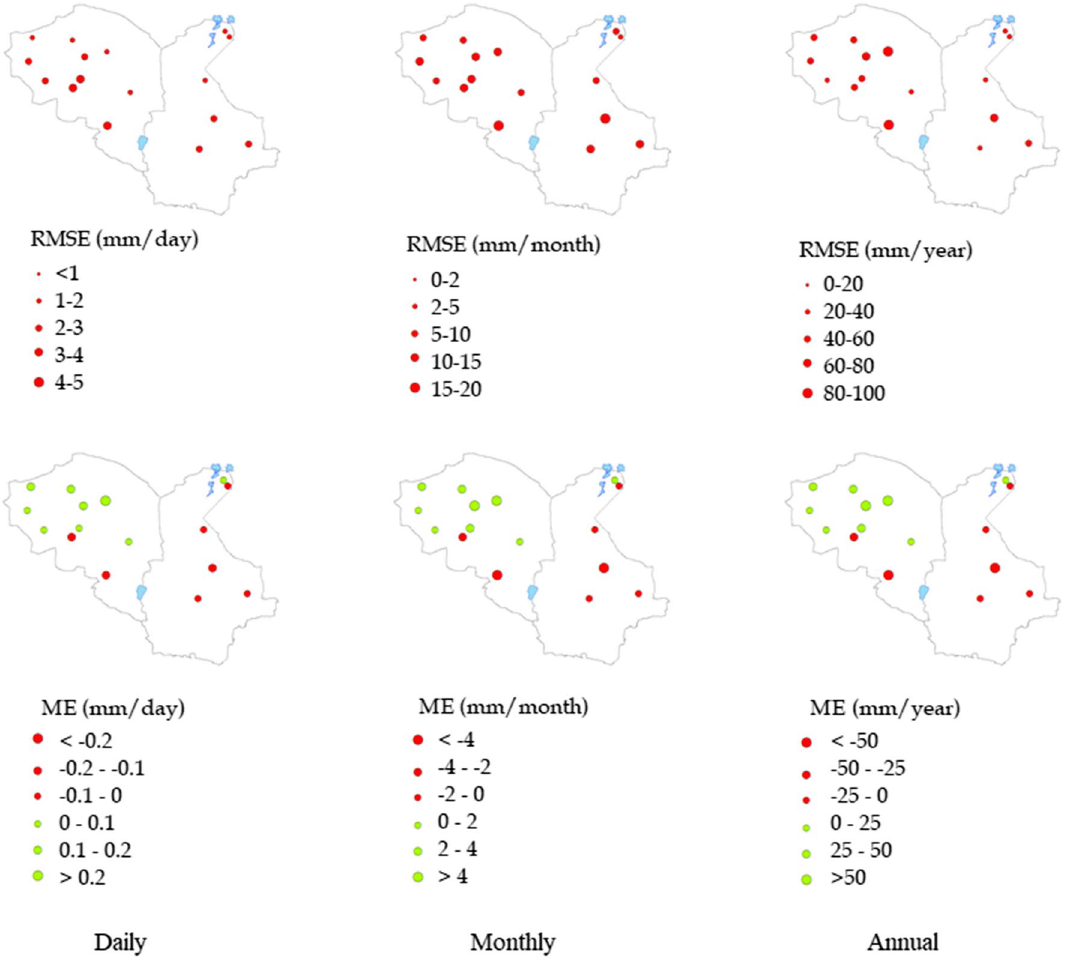
Fig. 4 Comparison of CHIRPS precipitation estimation with rain gauge data by RMSE and ME at daily, monthly, and annual